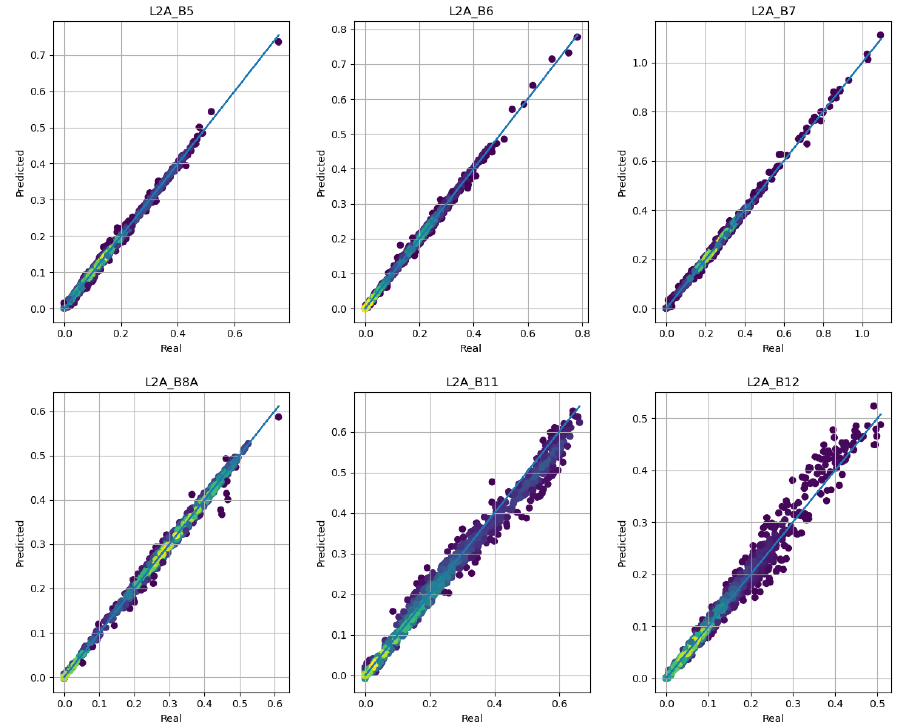
Figure 8. Scatterplots for the single-band regression (L2A). The colors Figure 7. Scatterplots for the single band regression (L1C). The colors indicate the density of